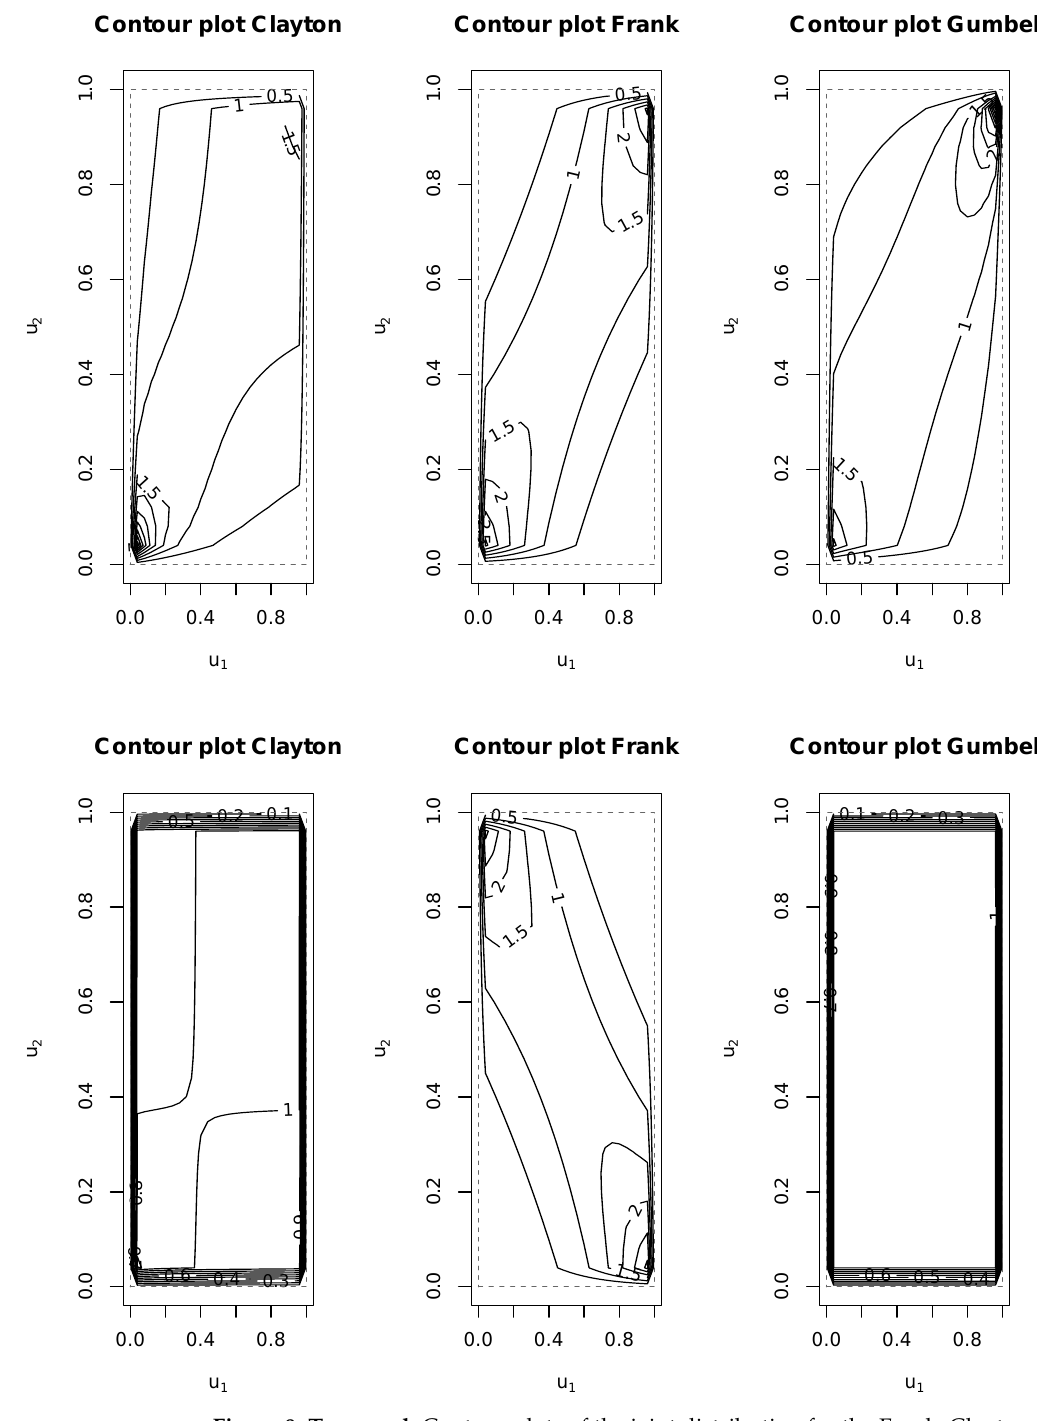
Figure 8. Top panel: Contour plots of the joint distribution for the Frank, Clayton and Gumbel for GHI against temp. bottom panel: Contour plots of the joint distribution for the Frank, Clayton and Gumbel for GHI against